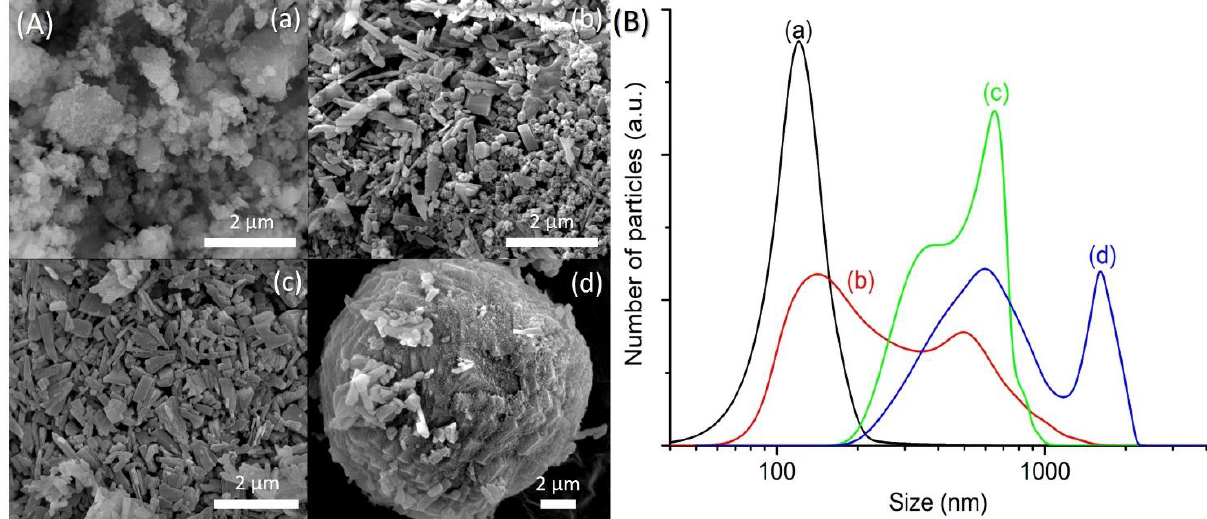
Figure 2. ( A ) Field emission scanning electron microscope (FESEM) images and ( B ) particle size distributions of ( a ) SH1, ( b ) SH3, ( c ) SH4 and ( d ) SH5 samples after heating at 150 °C for 2 h, 8 h, 10 h, and 14 h, respectively.